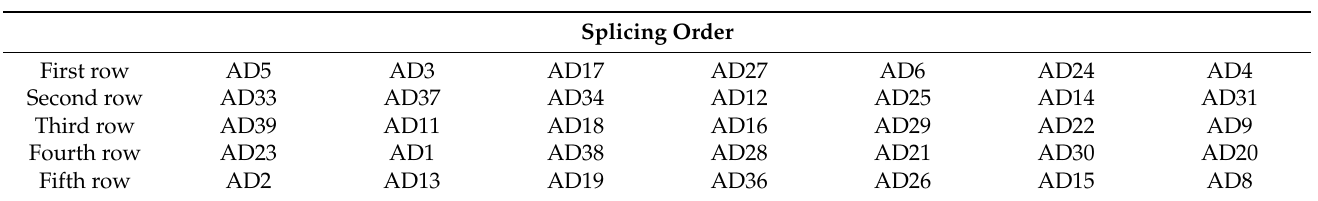
Table 6. Splicing of Case